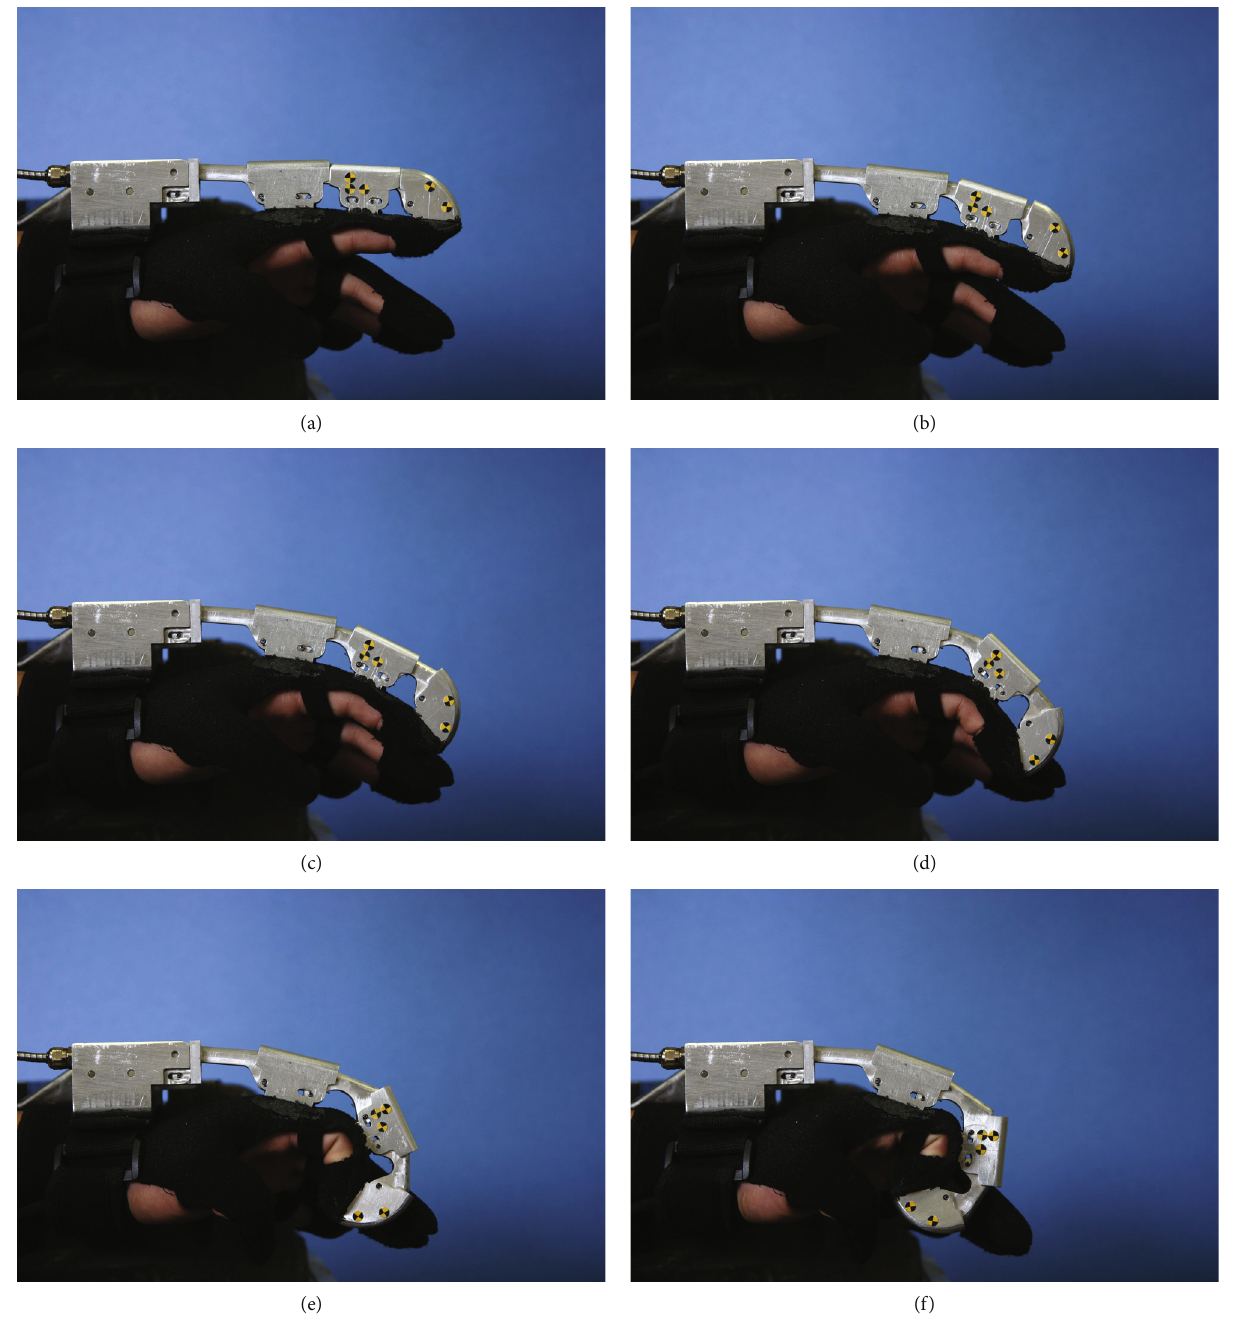
Figure 7: Images series acquired during the model building process.